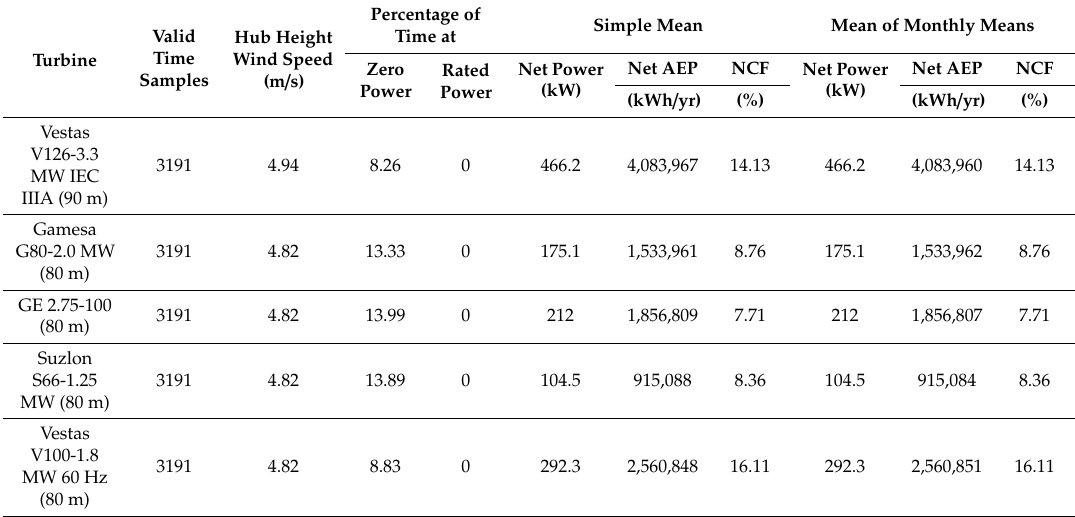
Figure 18. Gross mean power output of the Vestas V126-3.3 MW wind turbine. Source: generated by the software. Table 4. Power and energy of several wind turbine models. Source: the authors.